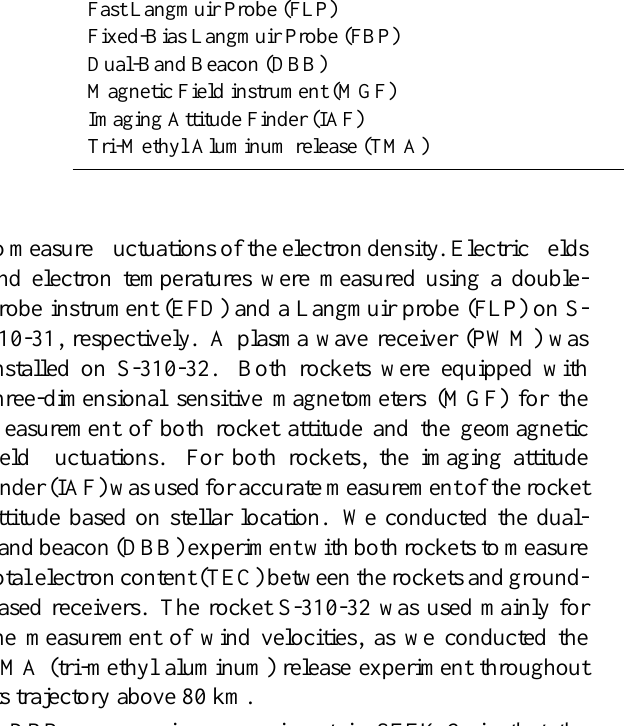
Table 2. Instruments boarded on the sounding rockets S-310-31 and S-310-32 and directing institutes. Instrument S-310-31 S-310-32 Institute Electric Field Detector (EFD) X Kyoto Univ. and NASA Number density of Electrons by Impedance probe (NEI) X X Tohoku Univ. Plasma and Wave Monitor (PWM) X Tohoku Univ. Fast Langmuir Probe (FLP) X ISAS/JAXA Fixed-Bias Langmuir Probe (FBP) X NiCT Dual-Band Beacon (DBB) X X Kyoto Univ. and NRL Magnetic Field instrument (MGF) X X Tokai Univ. Imaging Attitude Finder (IAF) X X Univ. of Tokyo Tri-Methyl Aluminum release (TMA) X Kyoto Univ. and Clemson